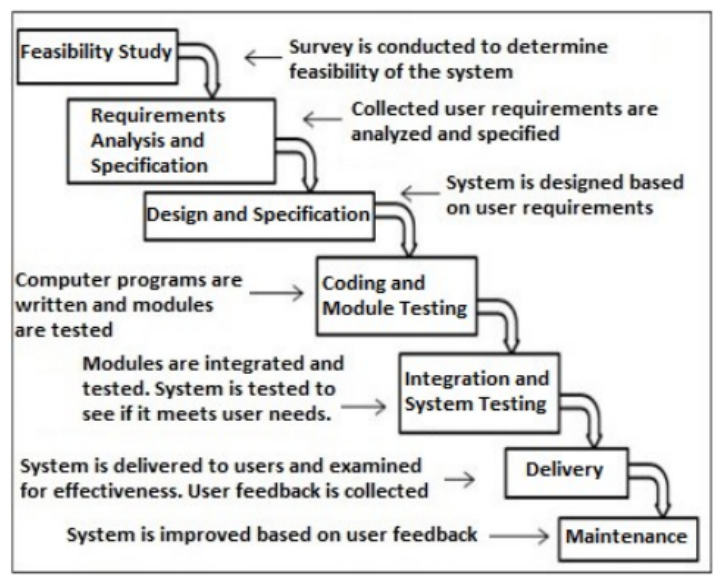
Figure 5. Waterfall software development